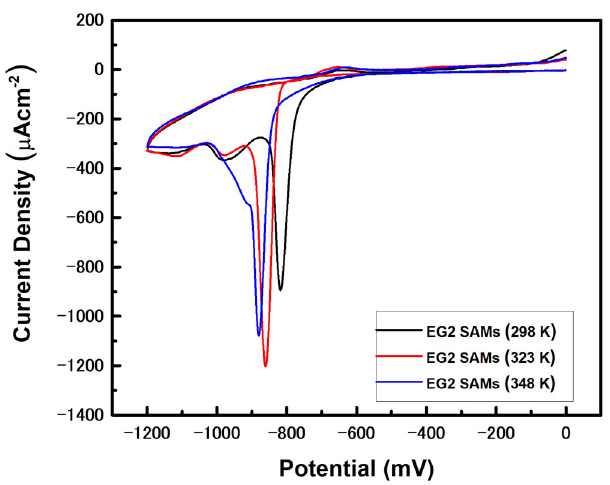
Figure 5. Cyclic voltammograms (CVs) of the reductive desorption of EG2 SAM-modified Au work- ing electrodes formed at the various deposition temperature of 298 K, 323 K, and 348 K in a 0.1 M KOH solution. The reductive desorption CVs were recorded by cycling in the potential range of 0 to −1.2 V at a rate of 0.4 Vs −1